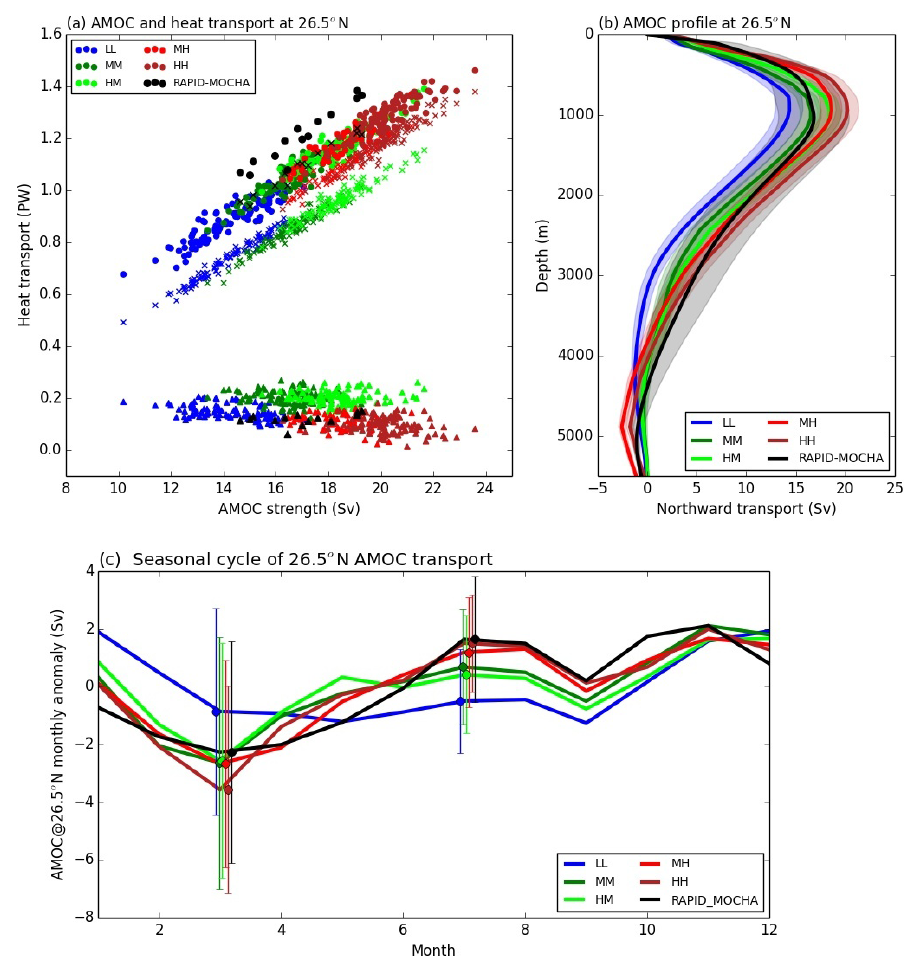
Figure 15. AMOC-related metrics calculated using RapidMoc code (C. D. Roberts, 2017) consistent with the RAPID-MOCHA observations, using model years 1–100. (a) Scatter plot of each annual mean AMOC transport ( x axis), with associated total heat transport ( y axis) decomposed into total (circles), overturning circulation ( x ) and gyre transport (triangles). (b) Profile of AMOC transport with depth, shading 1 standard deviation on either side of the mean. (c) The seasonal cycle of AMOC at 26.5 ◦ N with annual mean value subtracted. The standard deviation is indicated for March and July